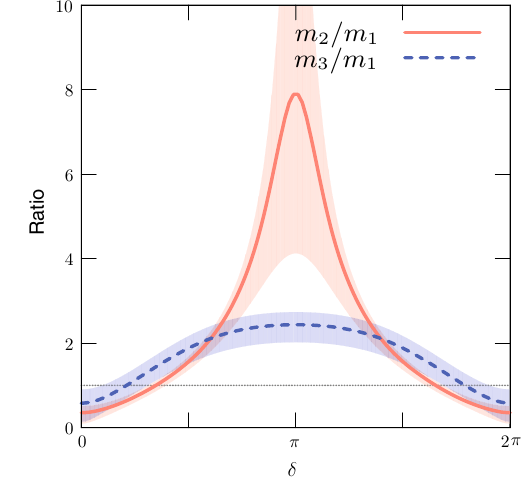
Fig. 1 The mass ratios m 2 / m 1 and m 3 / m 1 as functions of the Dirac CP phase δ , from Eq. (15). The bands show uncertainty coming from the 1 σ error in the neutrino mixing parameters. The thin dotted line corresponds to m 2 , 3 / m 1 = 1